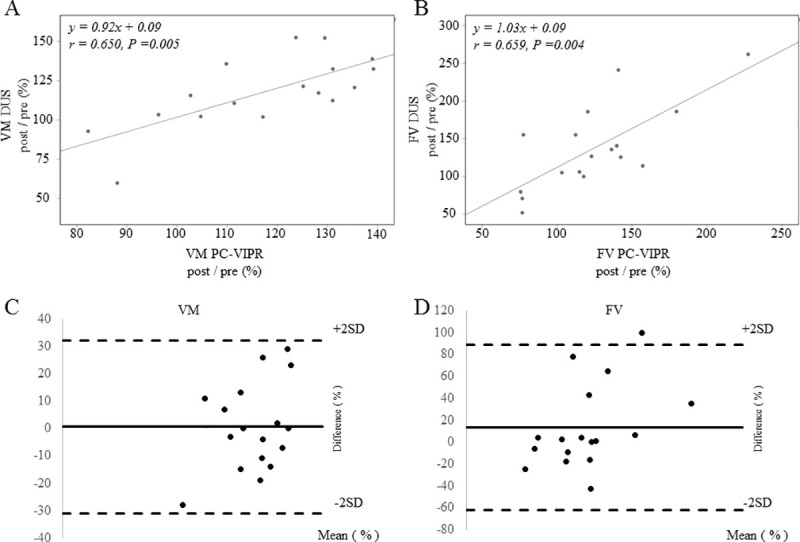
Correlation between the rates of change on DUS and 4D PC-VIPR.(A) Correlation between the rates of change on DUS and on 4D PC-VIPR at the peak velocity and peak cross-sectionally averaged velocity of the SMA (r = 0.650; p = 0.005, Spearman’s rank correlation coefficient). (B) Correlation between the rates of change on DUS and on 4D PC-VIPR in the blood FV of the SMA (r = 0.659; p = 0.004, Spearman’s rank correlation coefficient). Bland–Altman plots of the change rates before and after oral administration (post/pre) measured by 4D PC-VIPR and DUS for (C) the peak velocity and peak cross-sectionally averaged velocity and (D) blood FV. The y-axis shows the difference between the two measurements, and their mean is shown on the x-axis. The continuous line represents the bias; i.e., the mean of the differences, whereas the dotted lines indicate the limits of agreement (bias ± 2 SD).